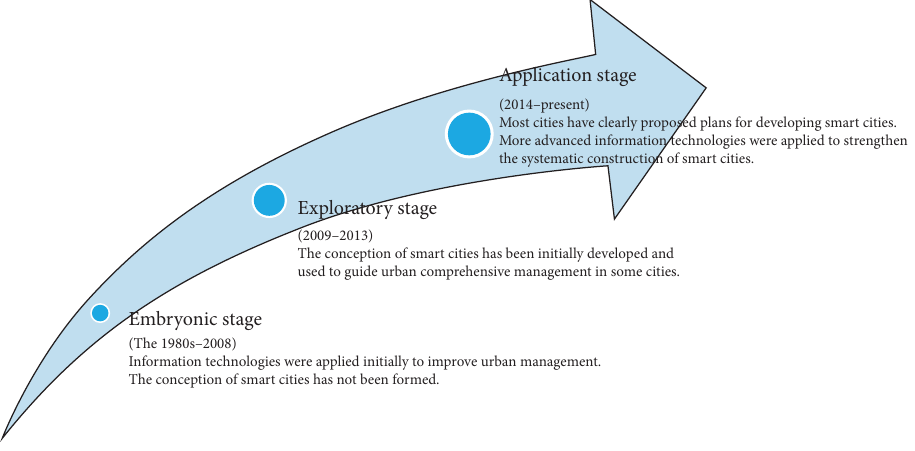
Figure 1 : Development of the conception of smart